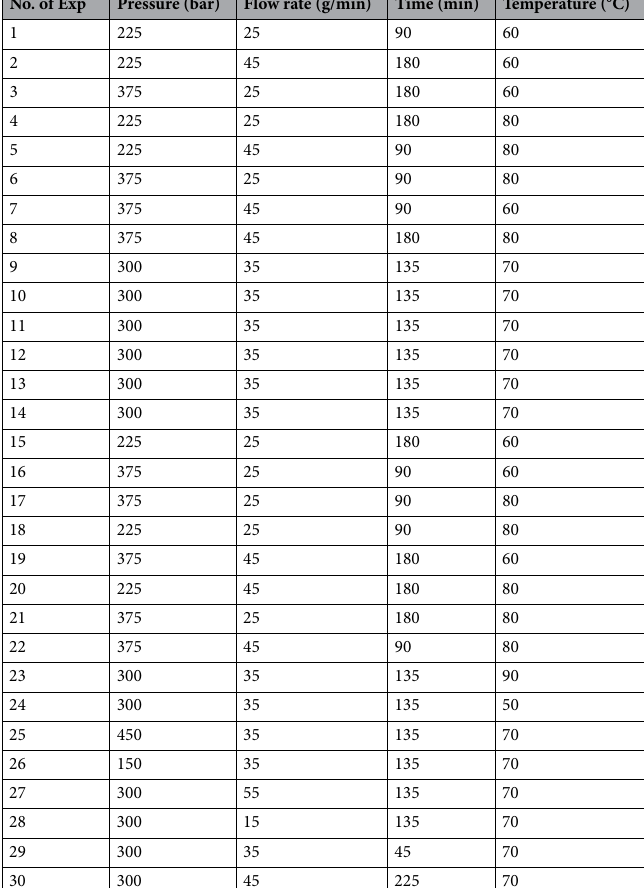
Table 1. Experimental